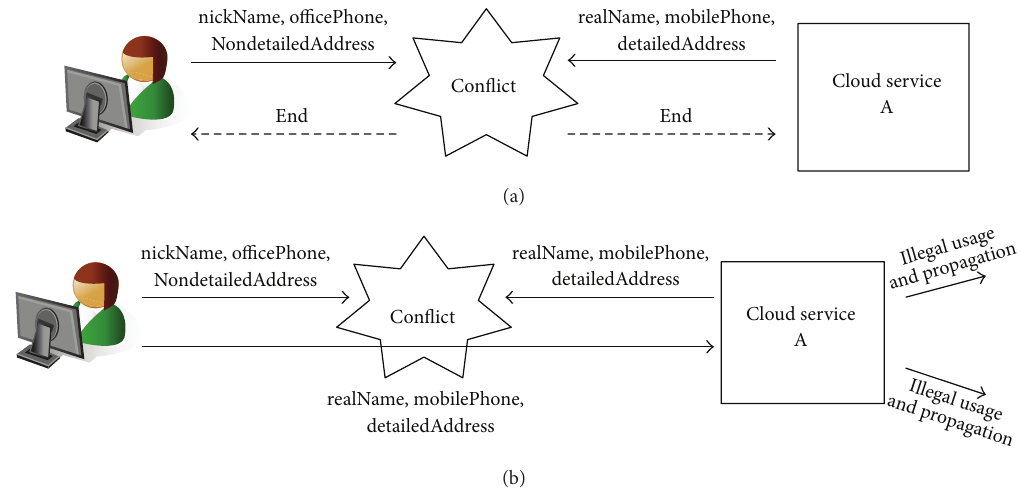
Figure 1: (a) Service is terminated because of privacy conflict. (b) Service proceeded with privacy information